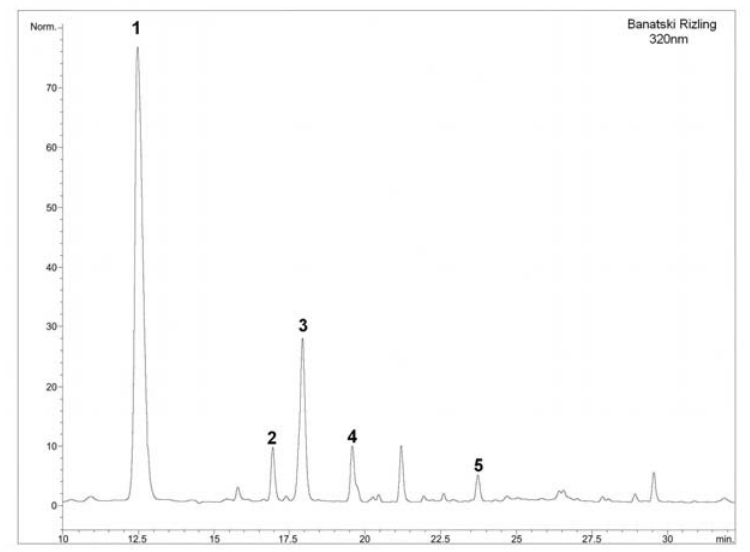
Figure 3. Chromatogram of a white wine. Identification of compounds: t-caftaric acid (1), GRP (2), trans -coutaric acid (3), caffeic acid (4), p -coumaric acid